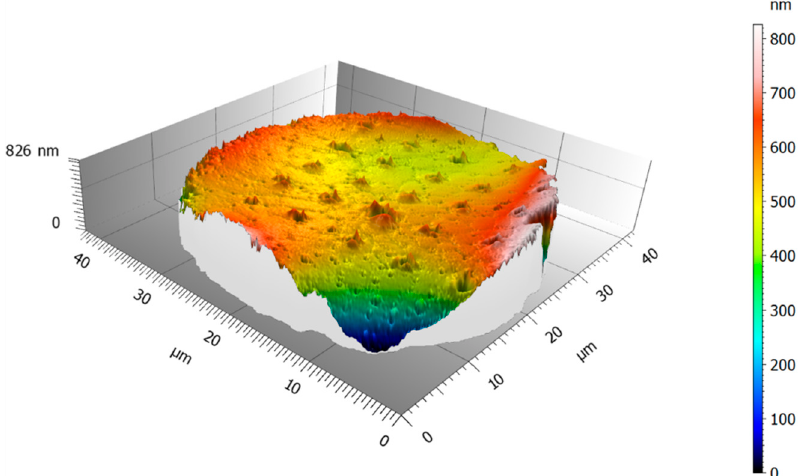
Figure 6. Surface topography obtained by way of applying 3D confocal microscopy-based analysis to the pile-up associated with a nano-indented gas-atomized Al 6061 powder particle mounted in cold castable epoxy and sourced from Company B. Conventionally static nanoindentation was performed to produce the residual indentation marks captured herein.